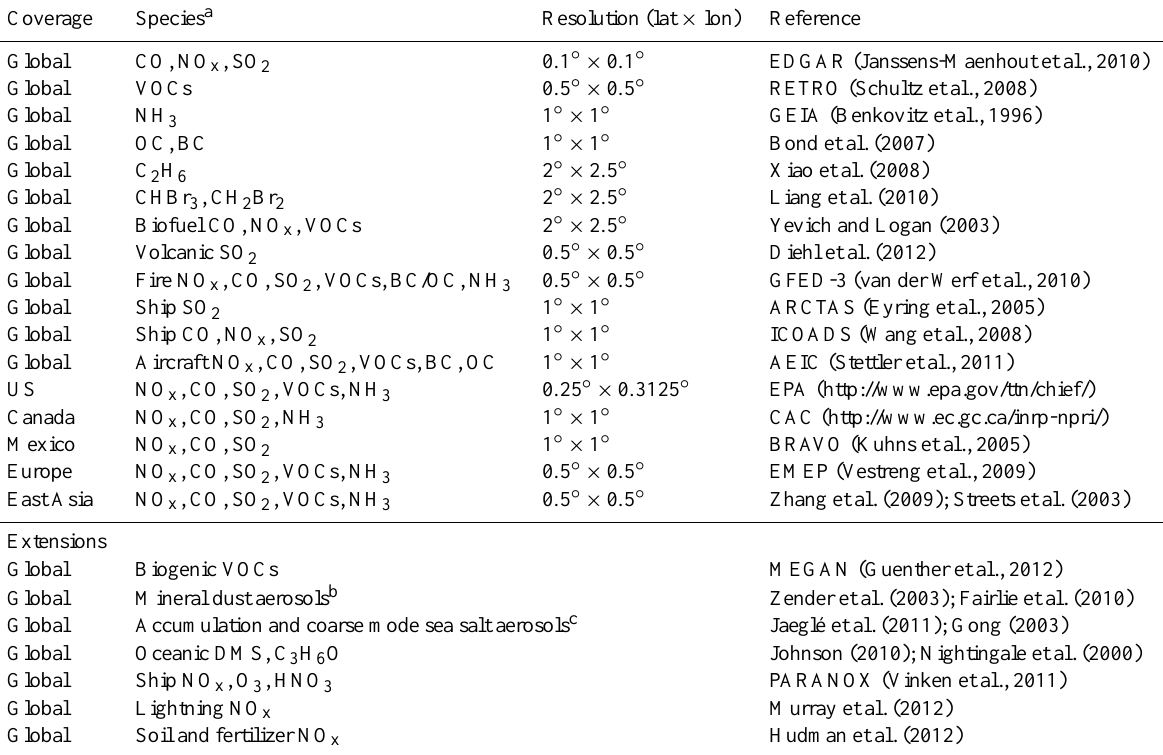
Table 1. Sample emission inventories currently in the HEMCO library. The horizontal resolution of the extensions is determined by the meteorological input